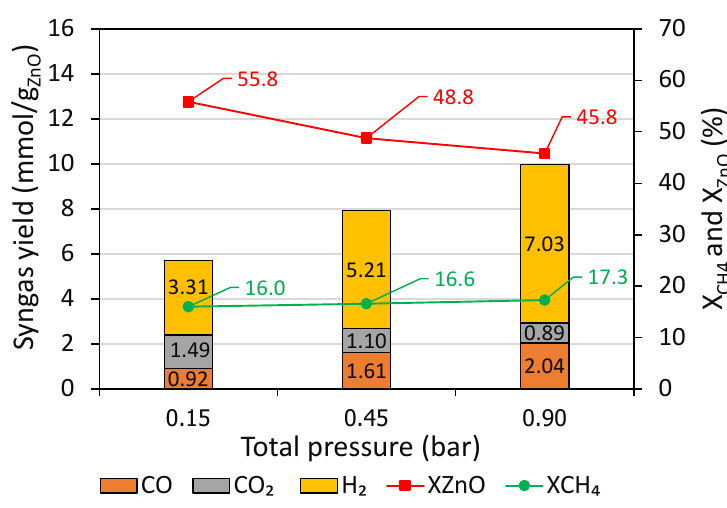
Figure 3. Syngas yield, methane conversion (X CH4 ), and net ZnO conversion (X ZnO ) as a function of pressure at 900 °C. Source: author.